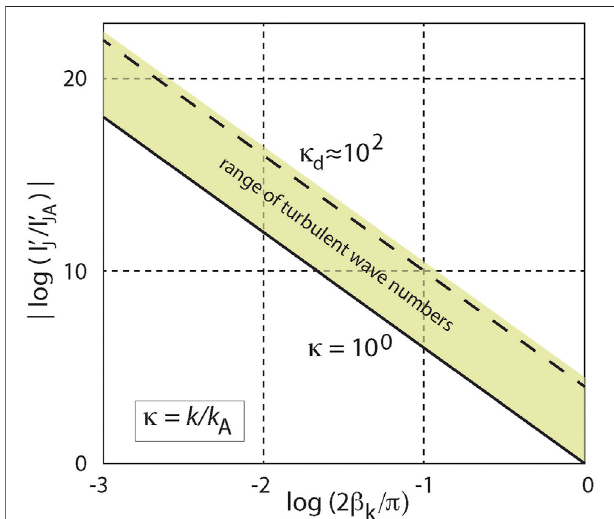
FIGURE 2 | Dependence of the normalized intensity per frequency ( dI / d ω J )/( dI / d ω JA )onthedecreaseintheangle10 − 3 ≤ 2 π β k ≤ 1fortworatios κ ≡ k / k A of turbulent wave numbers in the range 0.1 k A < k < k d under the assumption that k d λ e ≈ 1istheturbulentdissipationscaleandturbulentenergyinjectionisator below the Alfvénic scale k − 1 A . The ultimate turbulent dissipation scale k − 1 d is assumed to be two orders apart at κ ≈ 10 2 . The interval between the two lines indicates the spectral width of the turbulence in its contribution to Josephson radiation (shown in green). The radiation intensity increases drastically with decreasing angle β k , that is, with the obliqueness of the turbulent electric fi eld with respect to the normal to the